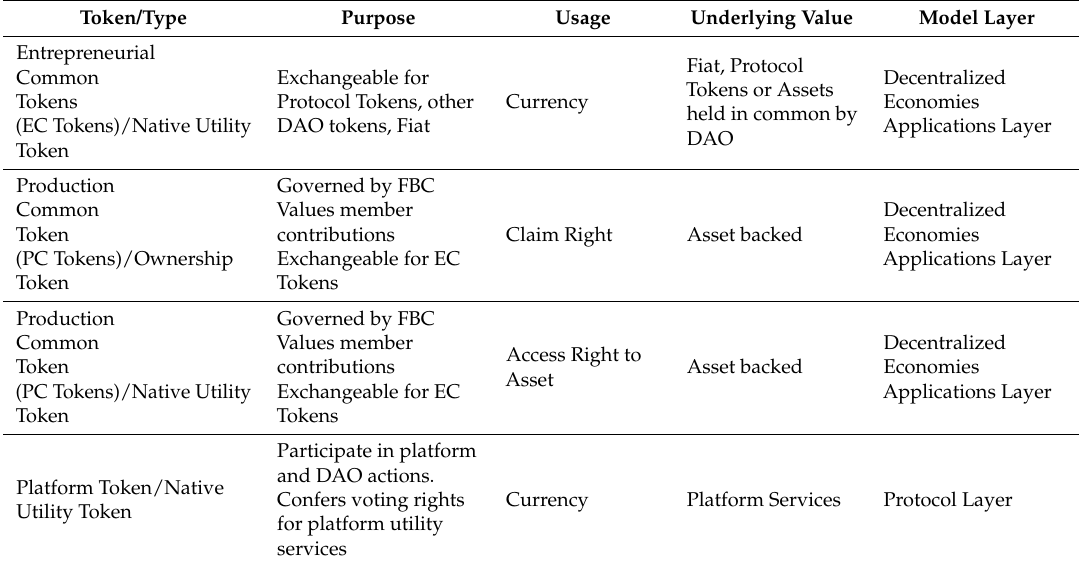
Table 1. Delineating token Types and their uses in a